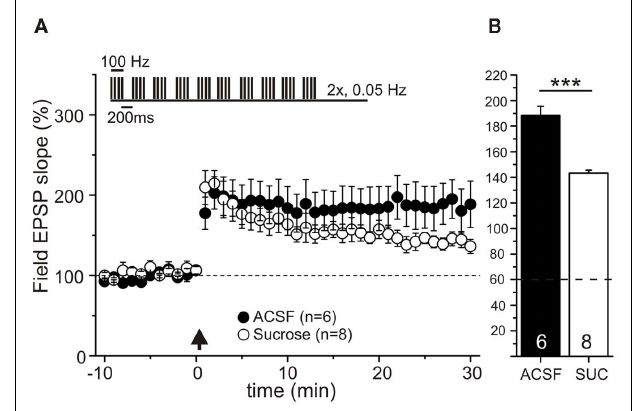
FIGURE 3 | e-LTP is reduced, but not abolished in sucrose prepared hippocampal slices. Field potential recordings in CA1 region of acute hippocampal slices of P18–23Wistar rats. Slices were prepared in sucrose containing ACSF (open circles, n = 8 slices of 3 animals, from 11 experiments) or in conventional ACSF (black dots, n = 6 slices of 3 animals, from 9 experiments). After recording of 10min baseline, e-LTP was induced by two theta-burst stimulations [interval 20s,TBS protocol is shown as inset, time point ofTBS stimulation: arrow (A) ].While short-term plasticity ( ≤ 20min) is similar for both groups, e-LTP (at 30min) is significantly stronger in ACSF prepared slices compared to sucrose preparation (B) . Data are normalized to baseline (average over 10min prior to theta-burst; set as 100%) and given in mean ± SEM, *** p < 0.0001, Mann–Whitney U -test. epileptiform discharges were observed (data not shown).